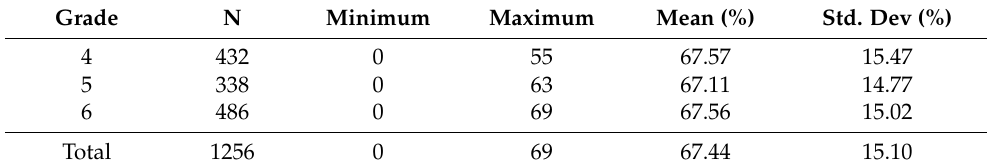
Table 13. Visual communication skills’ test standard deviations and means by